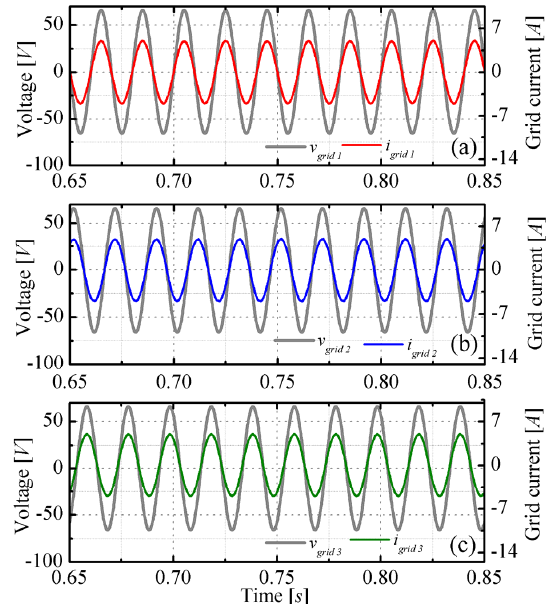
Figure 9. Partial shading: time behavior of the output currents compared to the grid voltages related to ( a ) phase 1; ( b ) phase 2; and ( c ) phase 3.